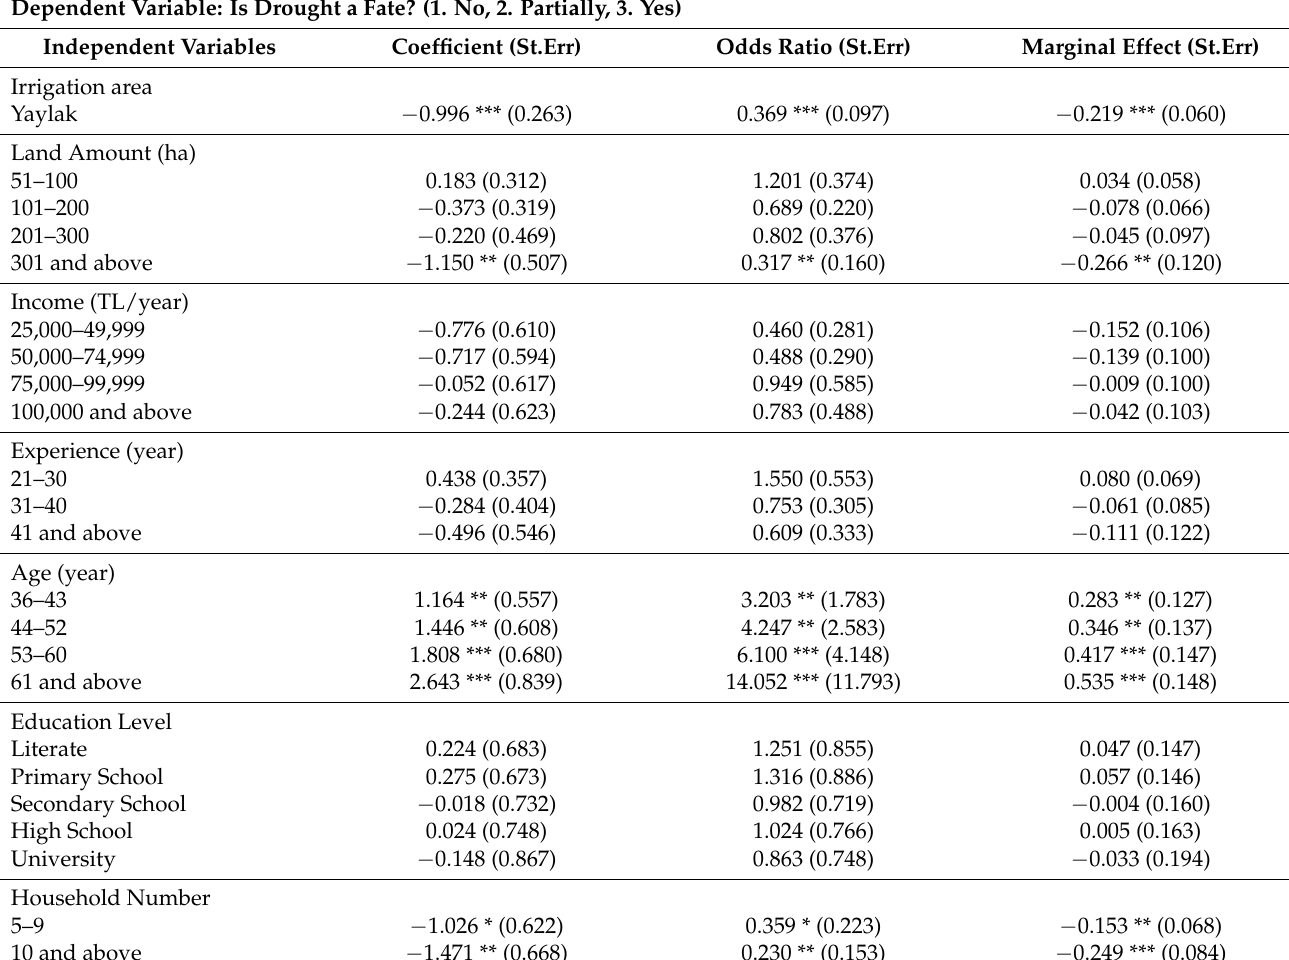
Table 2. Is drought a fate? Ordinal logit model